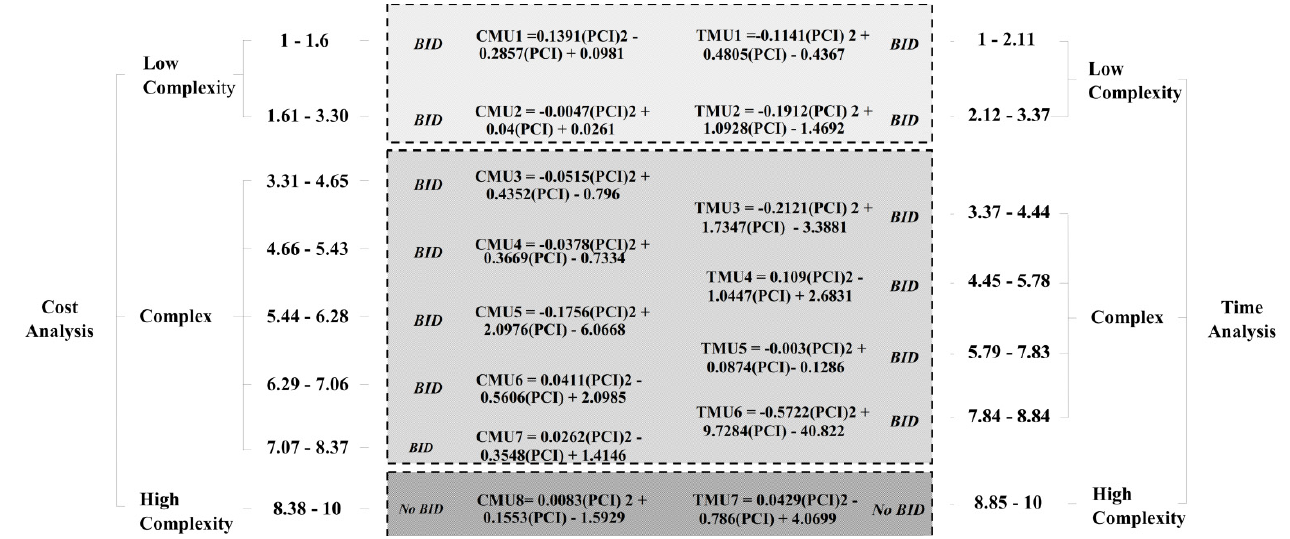
Figure 9. The presented model in the form of a decision tree of bid/no-bid and mark-up sizes.